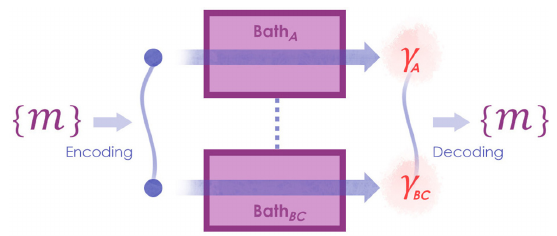
FIG. 1. Schematically, Theorem 6 implies that when local baths are classically correlated (the dashed line), it is possible to transmit classical information through locally performed full thermalization